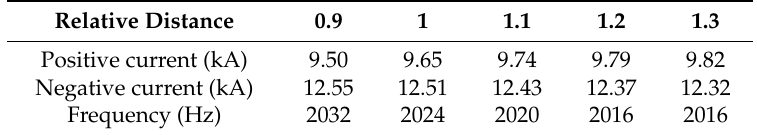
Table 2. The current and frequency with different distances between the oil tank and